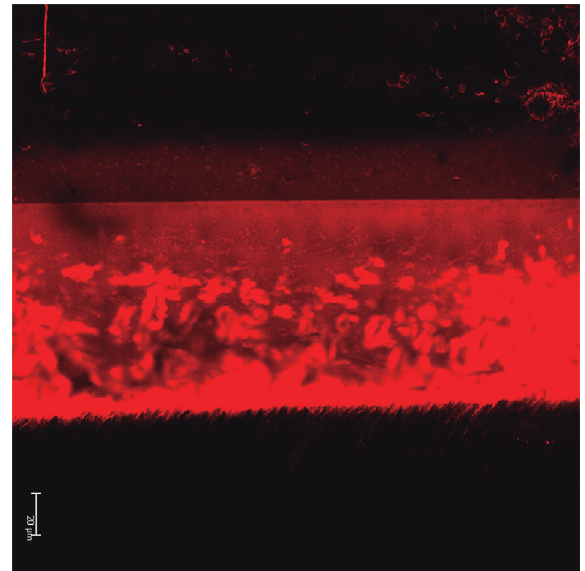
Figure 5b- Interface aspect of bonding system to enamel surface eroded by regular Coke (RC) followed by toothbrushing. Hybrid layer is irregular and superficial, but it is more evident than only eroded